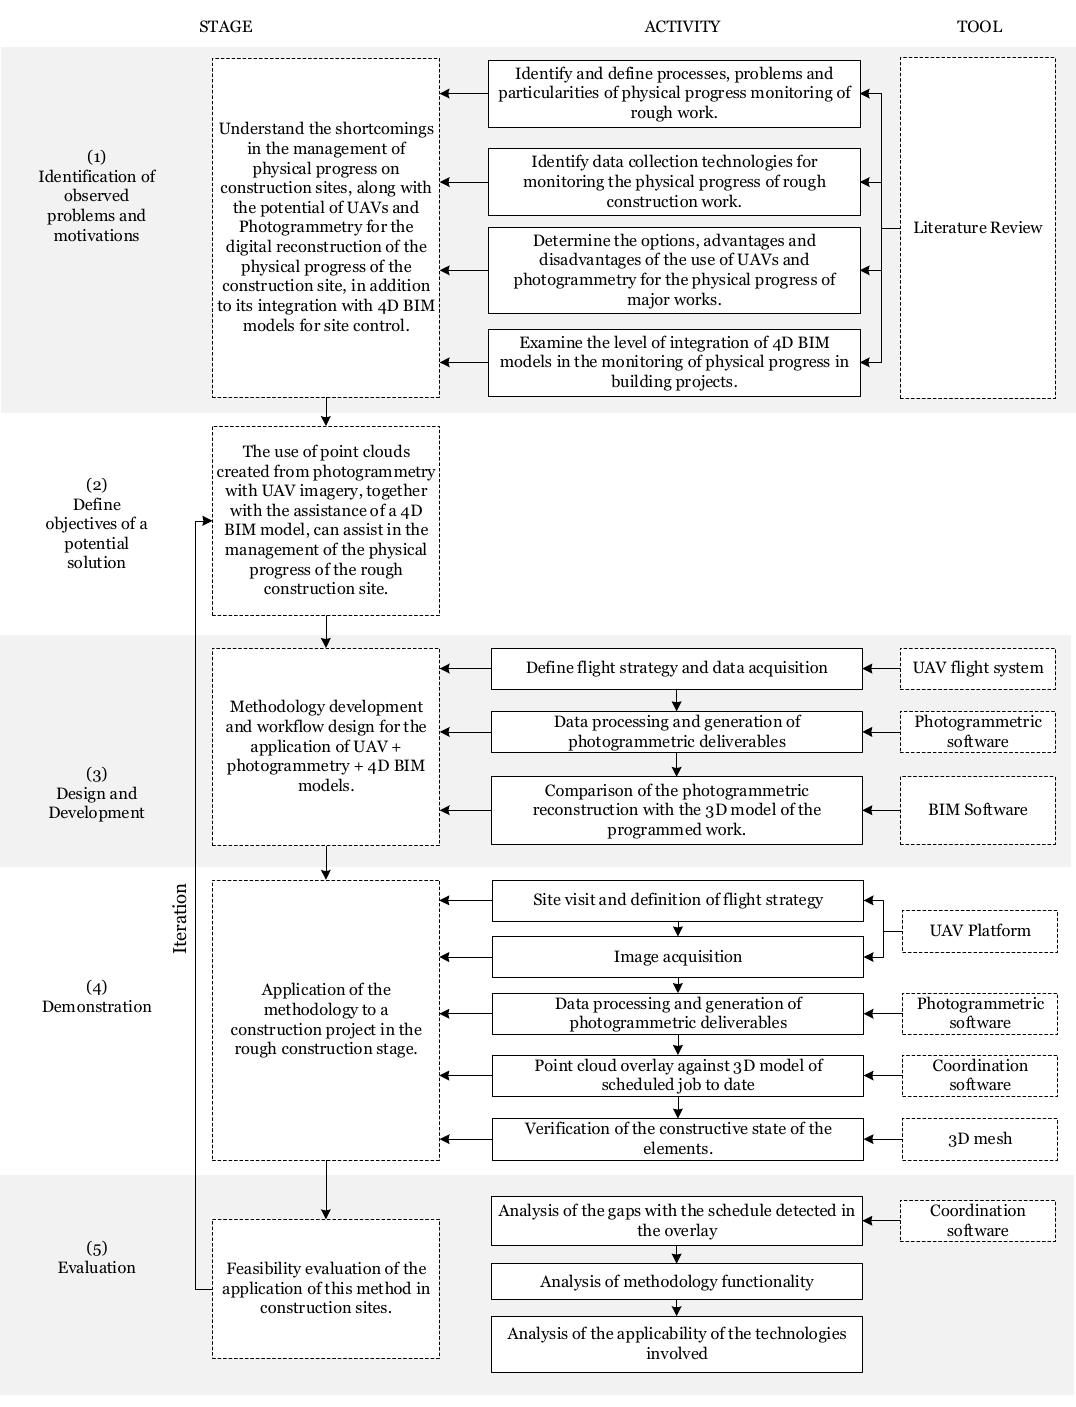
Figure 1. Research methodology.